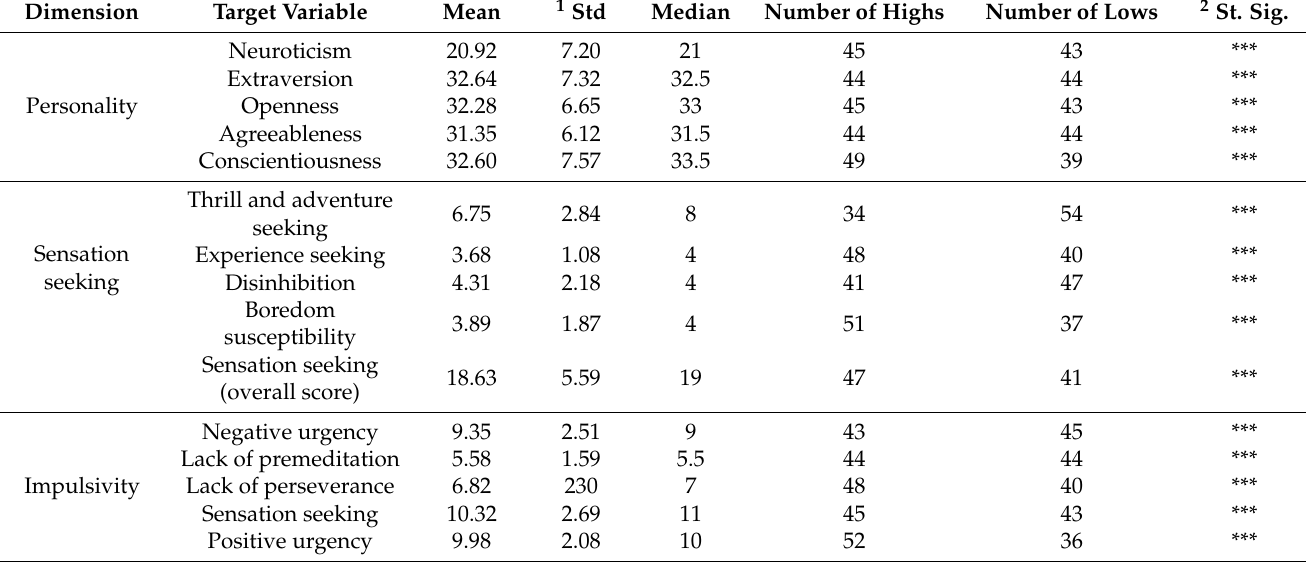
Table 3. Statistical description of each target variable.